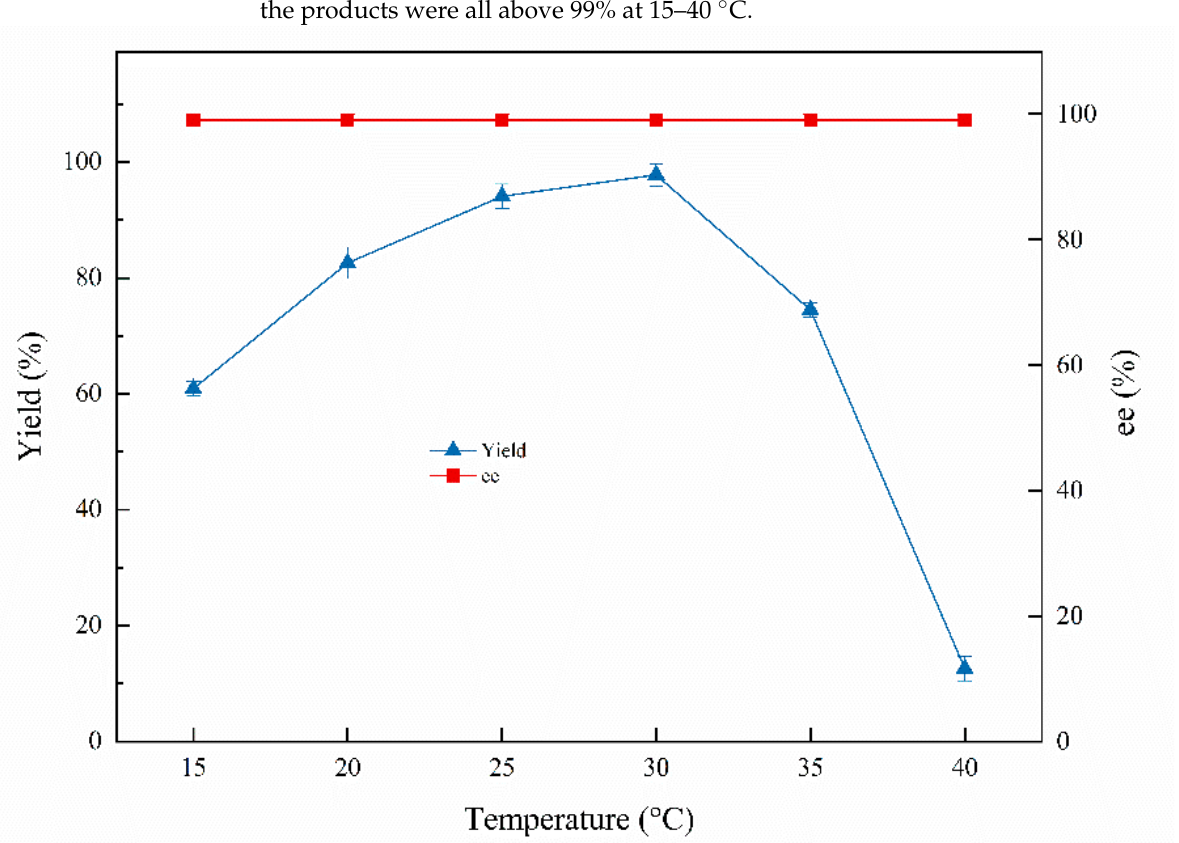
Figure 4. Effects of temperatures on the biocatalytic reduction. Reaction conditions: 20.0 mL K 2 HPO 4 -KH 2 PO 4 (100 mM, pH 6.0), 1.0 g resting cells (DCW), 50 mM 1-chloro-2-heptanone, 15% ( v/v ) IPA, different reaction temperature, 200 rpm, 24 h.